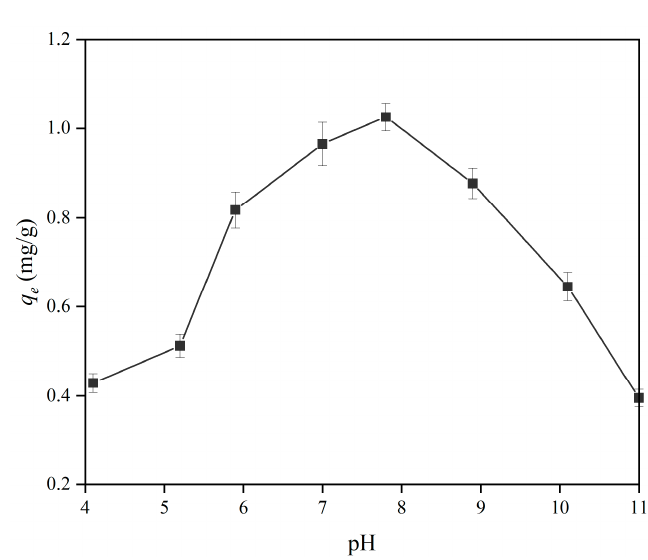
Figure 8. Effect of pH on the adsorption capacity of bio-ceramsite.